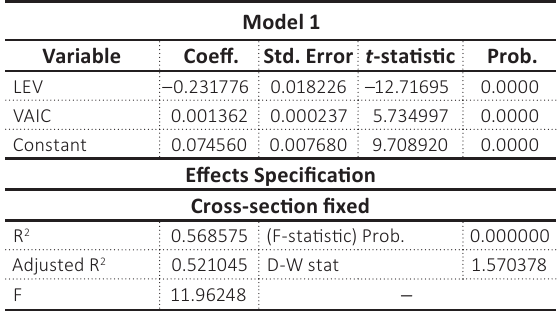
Table 10. Fixed effect models